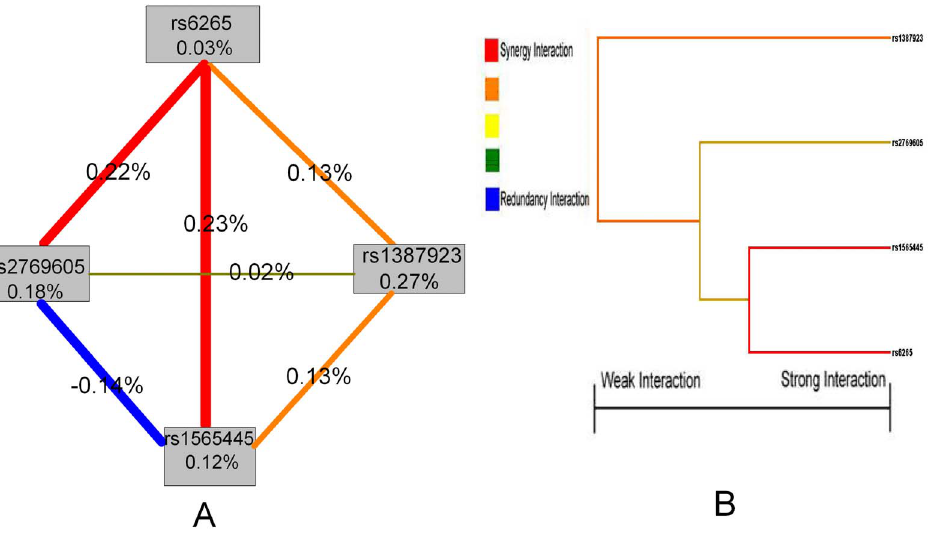
Figure 2. Hierarchical interaction graphs and interaction dendrogram. (A) Hierarchical interaction graphs showed that the percentage at the bottom of the each polymorphism represented entropy of it, and the percentage on each line represented the interaction percentage of entropy between two polymorphisms. The red line represented synergy redundancy interaction and the blue line represented redundancy interaction. (B) Interaction dendrogram showed that the red line represented synergy interaction and the orange line represented synergy interaction more weakly. From left to right the interaction was more intensive.